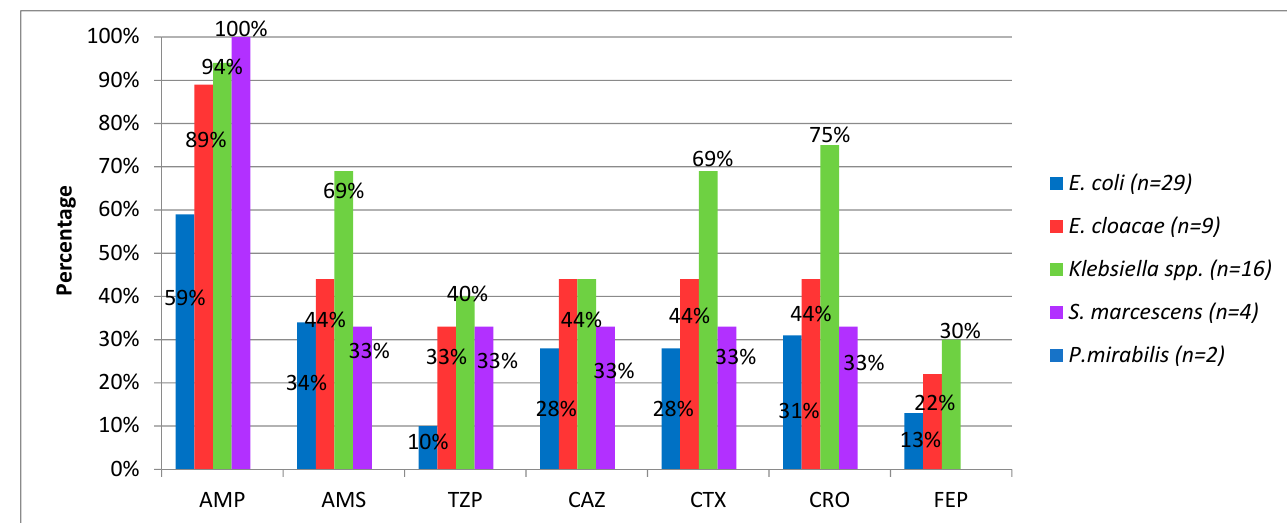
Figure 4. Percentage of beta-lactam resistance in Gram-negative bacilli causing neonatal infection. Havana, 2017–2018. AMP, ampicillin; AMS, ampicillin/sulbactam; TZP, piperacillin/tazobactam; CAZ, ceftazidime; CTX, cefotaxime; CRO, ceftriaxone; FEP, cefepime.